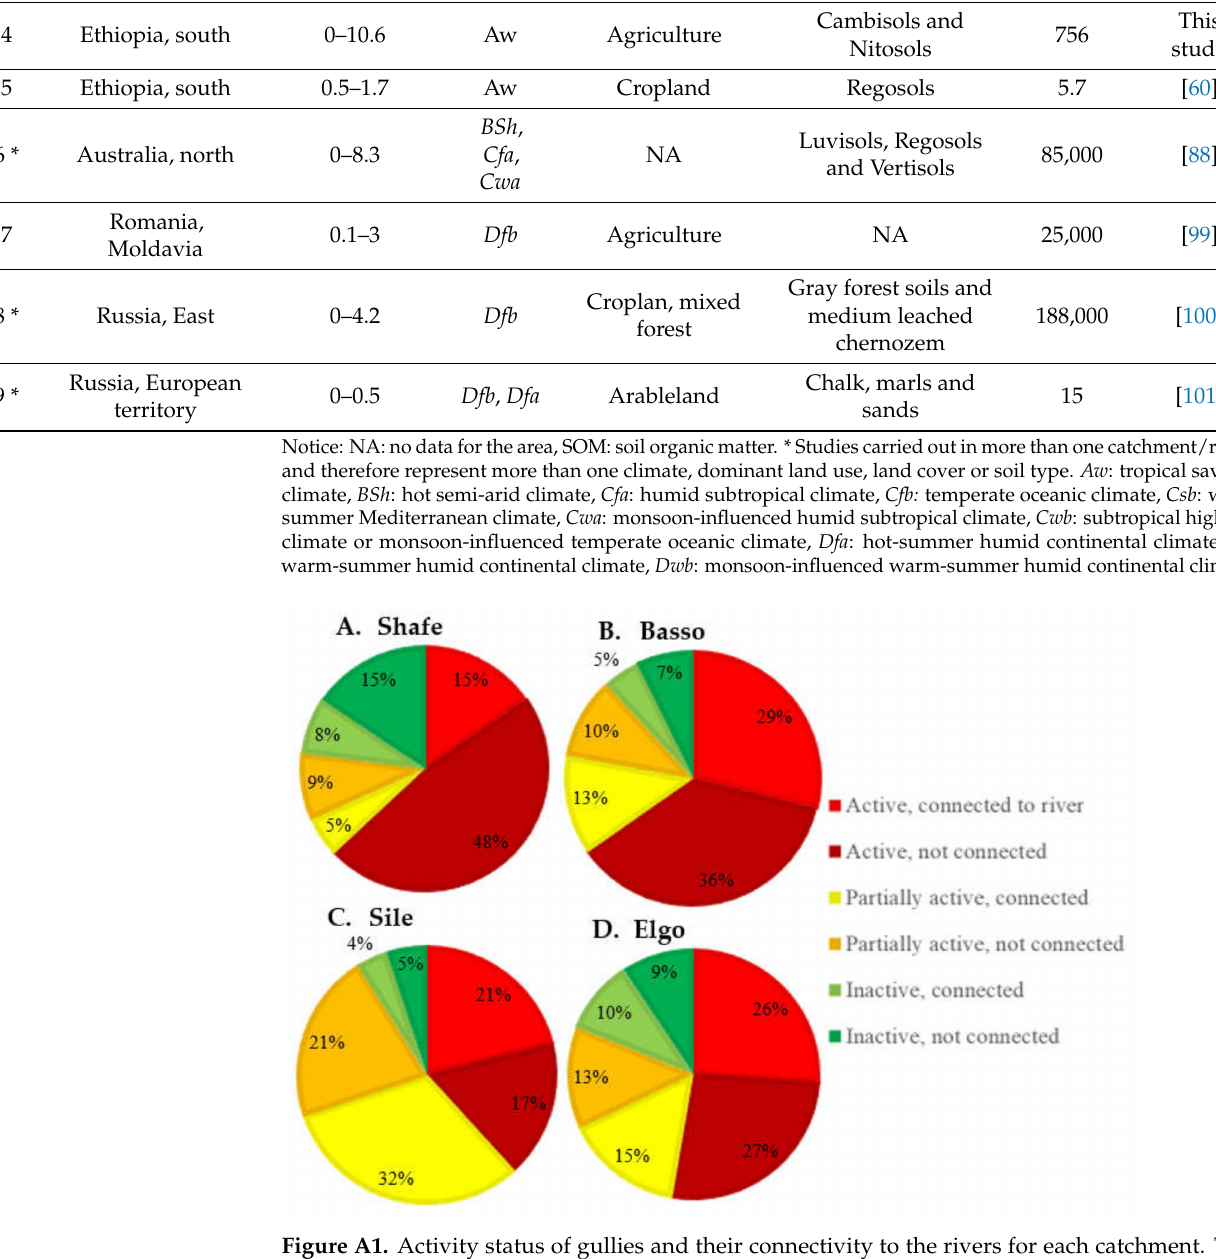
Figure A1. Activity status of gullies and their connectivity to the rivers for each catchment.